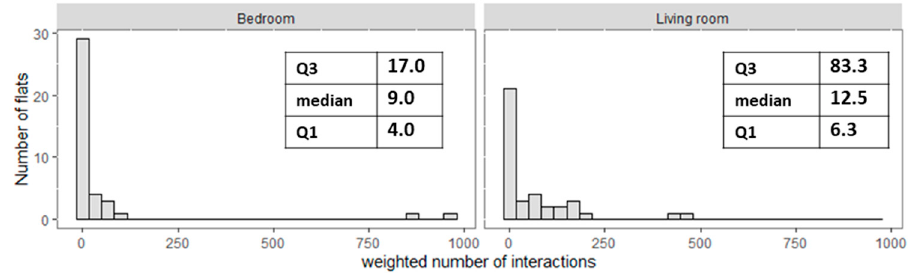
Figure 3. Distribution of the total number of interactions in living rooms and bedrooms. The interaction count was weighted by the number of observations from each flat.